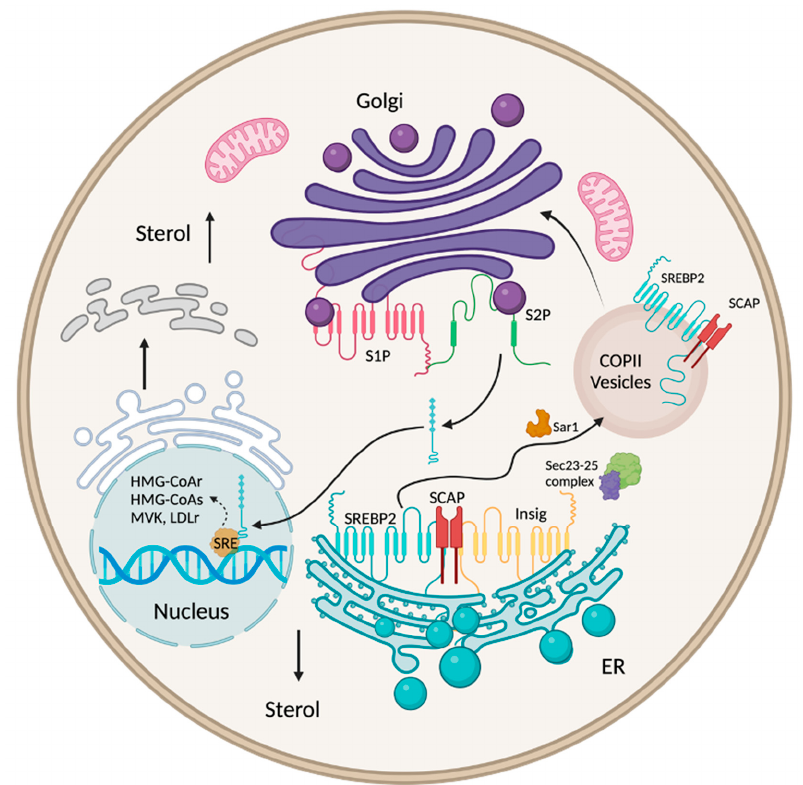
Figure 2. Regulation of cholesterol biosynthesis. SREBP-2 is the main regulator of cholesterol biosynthesis and is responsible for increases in blood cholesterol; it is attached to the ER membrane through its interaction with SCAP and INSIG1. When cholesterol levels decrease, INSIG1 is degraded, and the remaining SREBP-2–SCAP complex is inserted into the COPII vesicle in a process driven by GTPase and with the help of a protein complex consisting of Sar1 and Sec23–25. The SREBP-2–SCAP complex is transported to the Golgi by the COPII vesicle, where it is degraded by proteases S1P and S2P. This causes the release of the active domain of SREBP-2, which is transferred to the nucleus and binds to the SRE, resulting in the transcription of genes involved in cholesterol synthesis: HMGCR , HMG-CoA synthase , and MVK , as well as LDLR, which is responsible for cholesterol uptake. (Created with BioRender.com (accessed on 1 September 2022)).